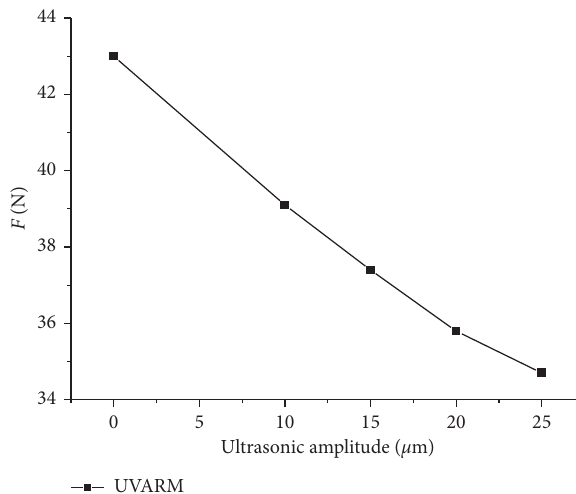
Figure 17: Fx changes with ultrasonic amplitude.